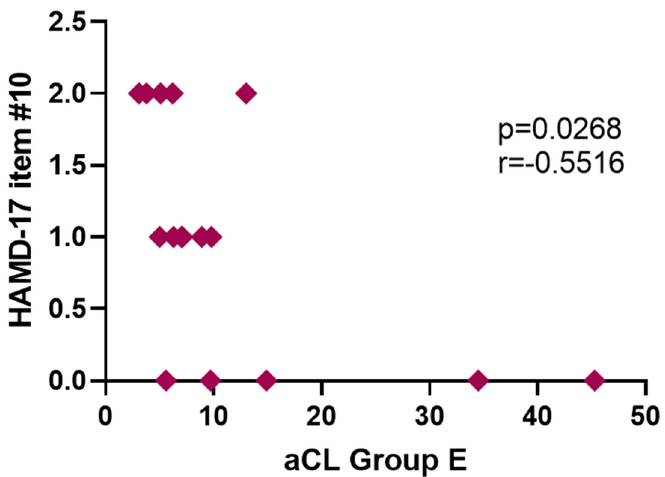
Figure 6. aCL IgM titers for Group E MDD patients in correlation with item #10 of HAMD-17 (Anxiety, Psychic) at week 12.